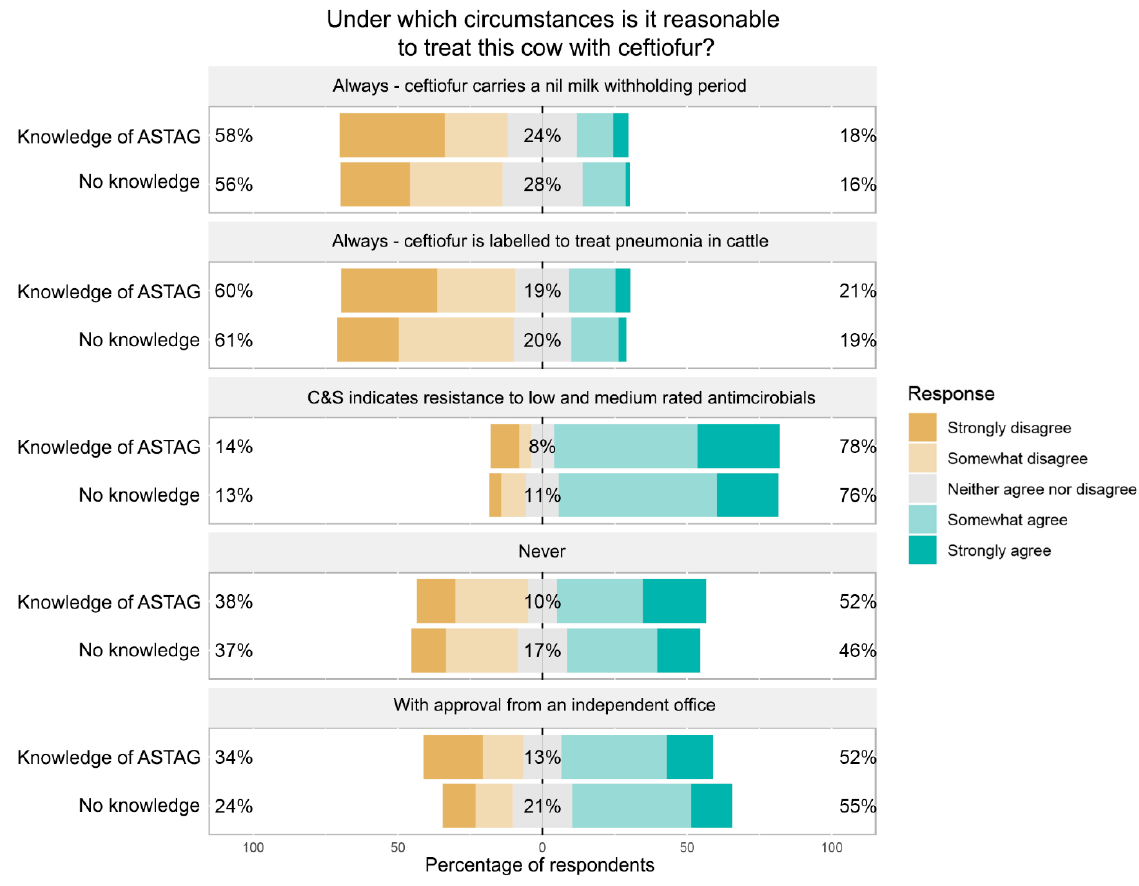
Figure 6. Responses of participants about the reasonableness of treating pneumonia in a cow with ceftiofur, with responses segregated based on the respondents’ knowledge of the ASTAG rating system.